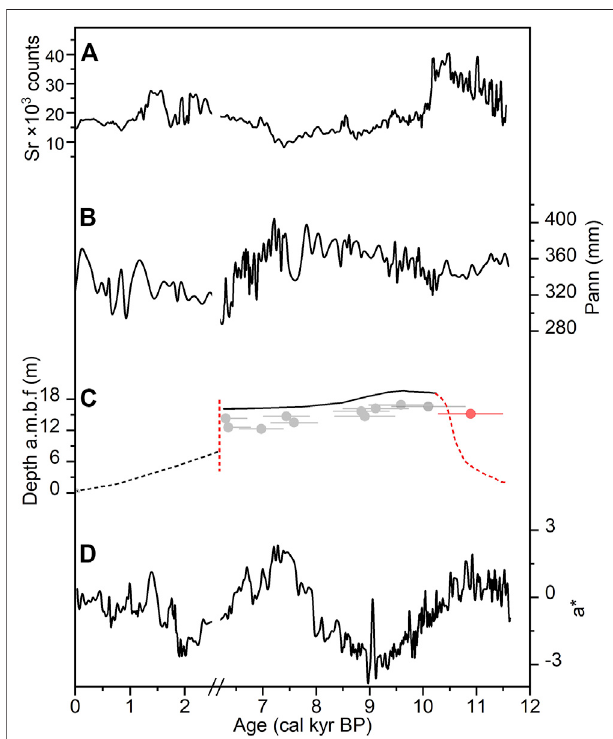
FIGURE7| ComparisonofdifferentclimaticrecordsinChaganNurlake. Sr content, (A) annual precipitation rebuilt by tree pollen (without pinus, Li et al., 2020), and (B) lake level ( C , reorganize according Li et al., 2020), redness (a*, d).